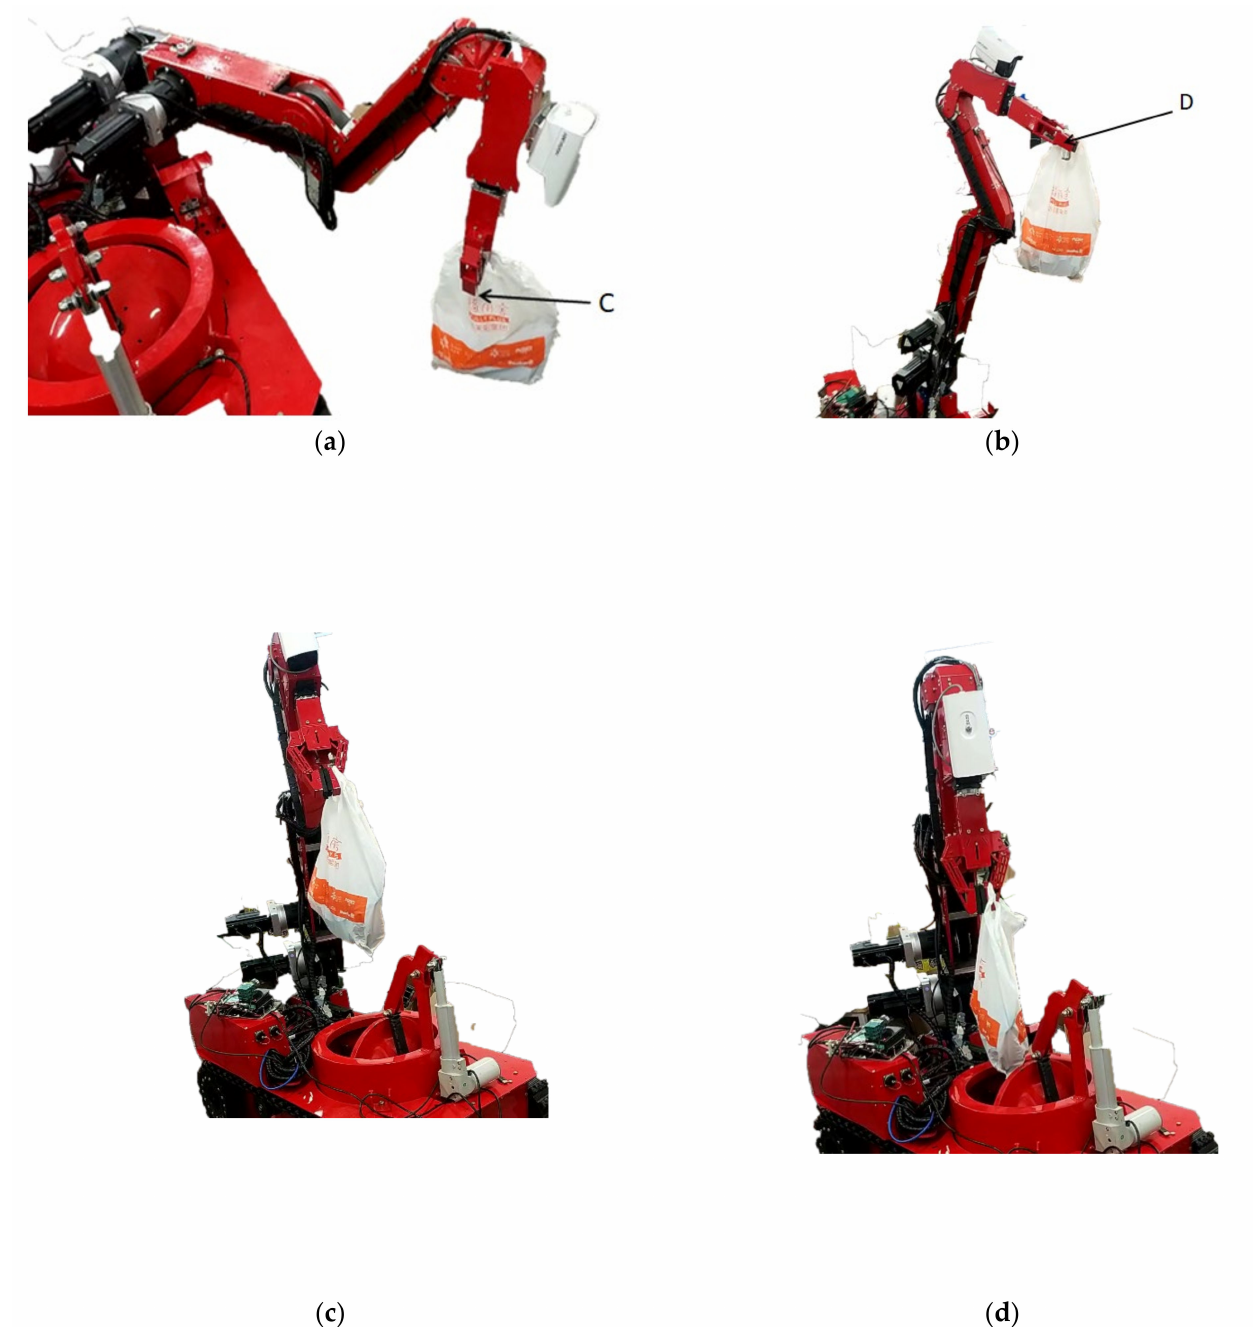
Figure 18. Experimental process of manipulator trajectory planning: ( a ) Control the mechanical claw to grasp the object; ( b ) The manipulator retracts the arm to the highest position; ( c ) Control the mechanical arm to the position above the explosion-proof tank; ( d ) Control the mechanical claw to grasp the object and put it into the explosion-proof